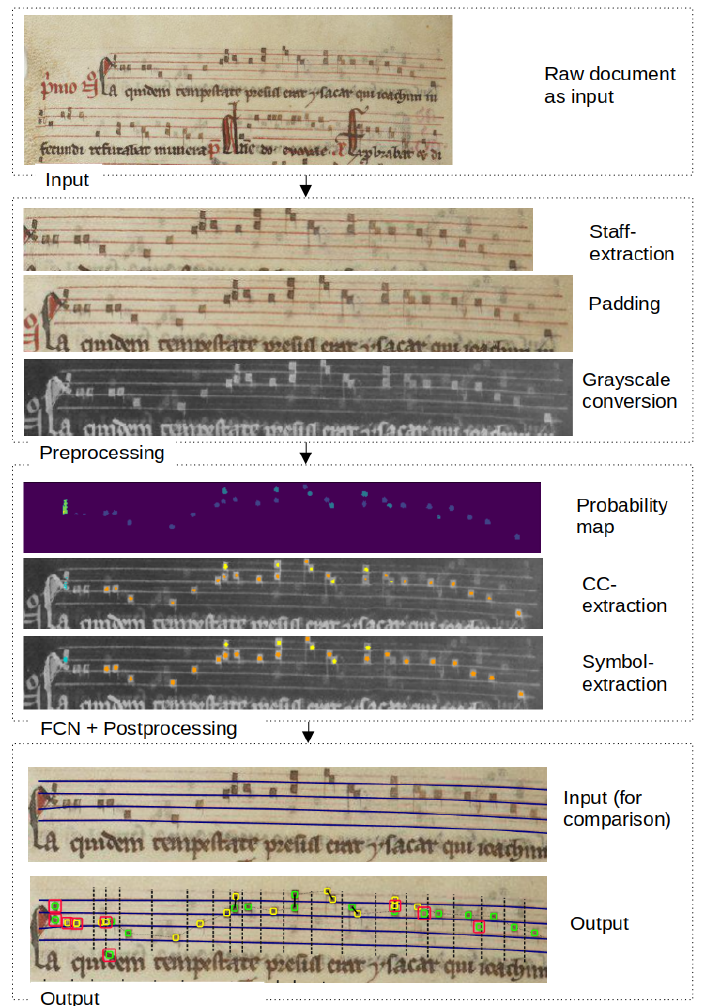
Figure 3. The schematic workflow of the proposed symbol detection. Additionally to the input and output of the algorithm, the output of the major intermediate steps is displayed. This includes the staff line extraction from the original images, the padding of the line images and the grayscale conversion. Furthermore, the segmentation and further post-processing steps are shown, which includes the probability map generation, the connected component and finally the symbol extraction. The symbols are segmented two times from the background, using two different thresholds. Squares with an additional red box are “uncertain” symbols, which are used within post-processing to correct errors